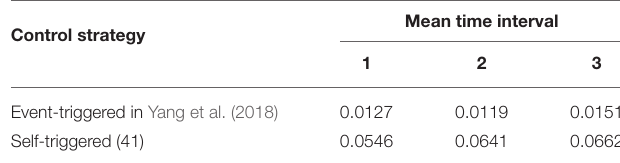
TABLE 2 | Mean time interval of follower